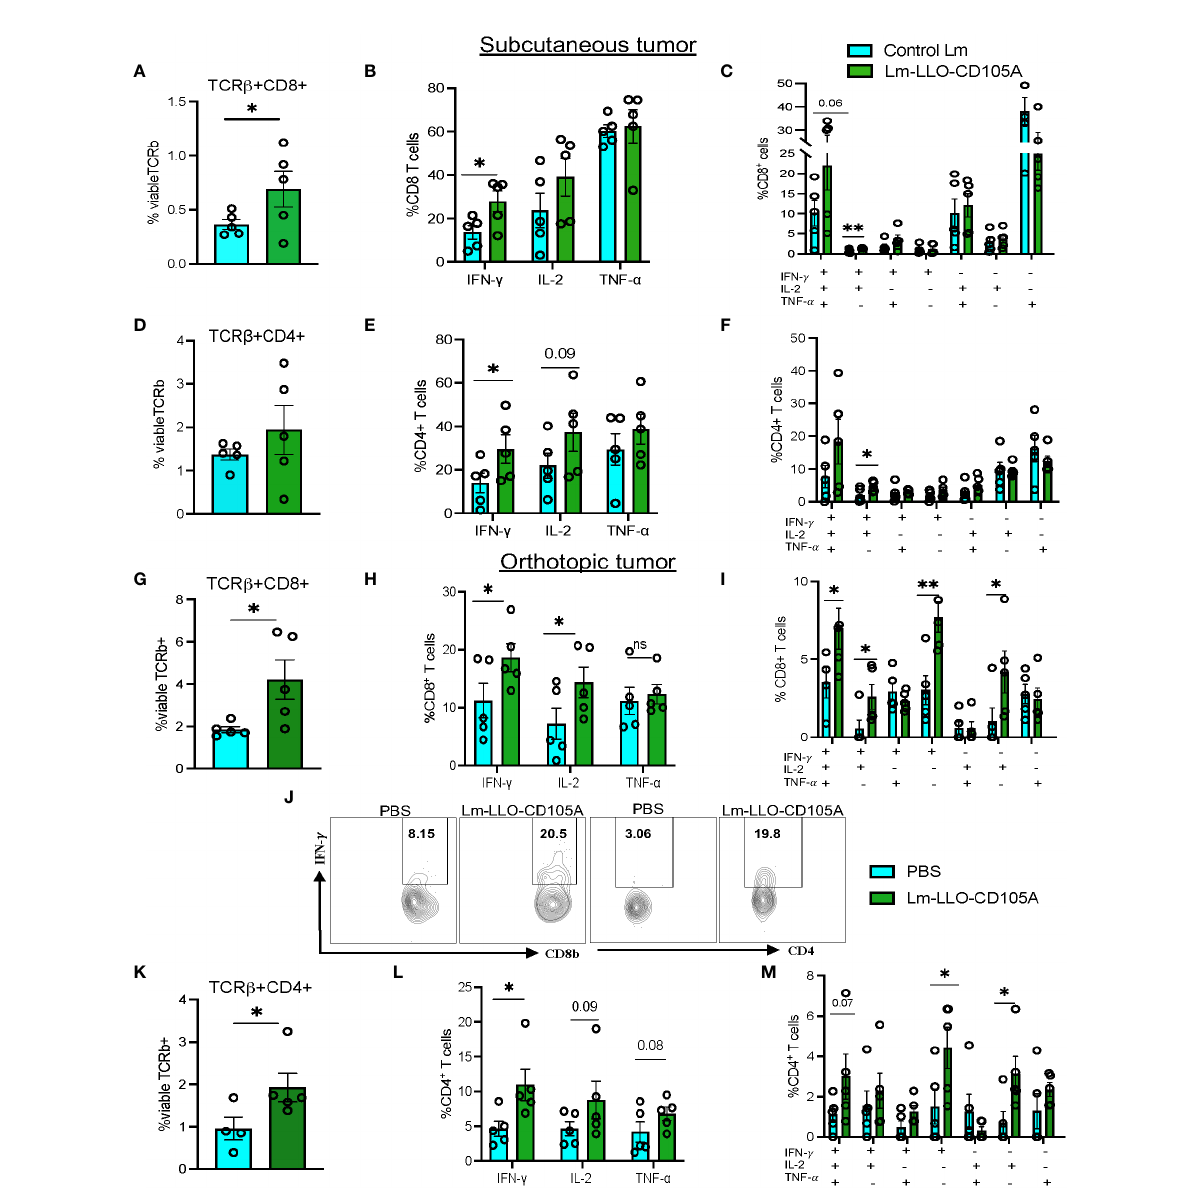
FIGURE 4 Lm-LLO-CD105A remodels the tumor microenvironment to improve T cell functionality. (A) Population of subcutaneous tumor-in fi ltrating CD8 + T cells. (B) Cytokine production by CD8 + T cells. (C) Population of multi-cytokine producing CD8 + T cells in the subcutaneous tumor. (D) Population of subcutaneous tumor-in fi ltrating CD4 + T cells. (E) Cytokine production by CD4 + T cells. (F) Population of multi-cytokine producing CD4 + T cells in the subcutaneous tumor. (G) Population of orthotopic tumor-in fi ltrating CD8 + T cells. (H) Cytokine production by orthotopic tumor-in fi ltrating CD8 + T cells. (I) Population of multi-cytokine producing CD8 + T cells in the orthotopic tumor. (J) Representative dot plot for IFN- g production by orthotopic tumor-in fi ltrating CD8 + and CD4 + T cells. (K) Population of orthotopic tumor-in fi ltrating CD4 + T cells (L) Cytokine production by orthotopic tumor-in fi ltrating CD4 + T cells. (M) Population of multicytokine producing CD4 + T cells in the orthotopic tumor.(n=5/group). Flow cytometry gating strategy for T cell function and myeloid cells is as shown in Supplementary Figures 3A-D. Polyfunctional CD4 +, and CD8 + T cells were identi fi ed using the Boolean gating function on fl owjo software. Data were analyzed using unpaired t-test. *P < 0.05, **P < 0.01, ns, not signi fi cant. All error bars are shown as mean ±